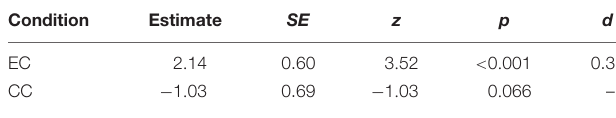
TABLE 4 | Estimated marginal means for LM3 [ F (3, 81) = 3.47, p = 0.020, R 2 = 0.11], Study